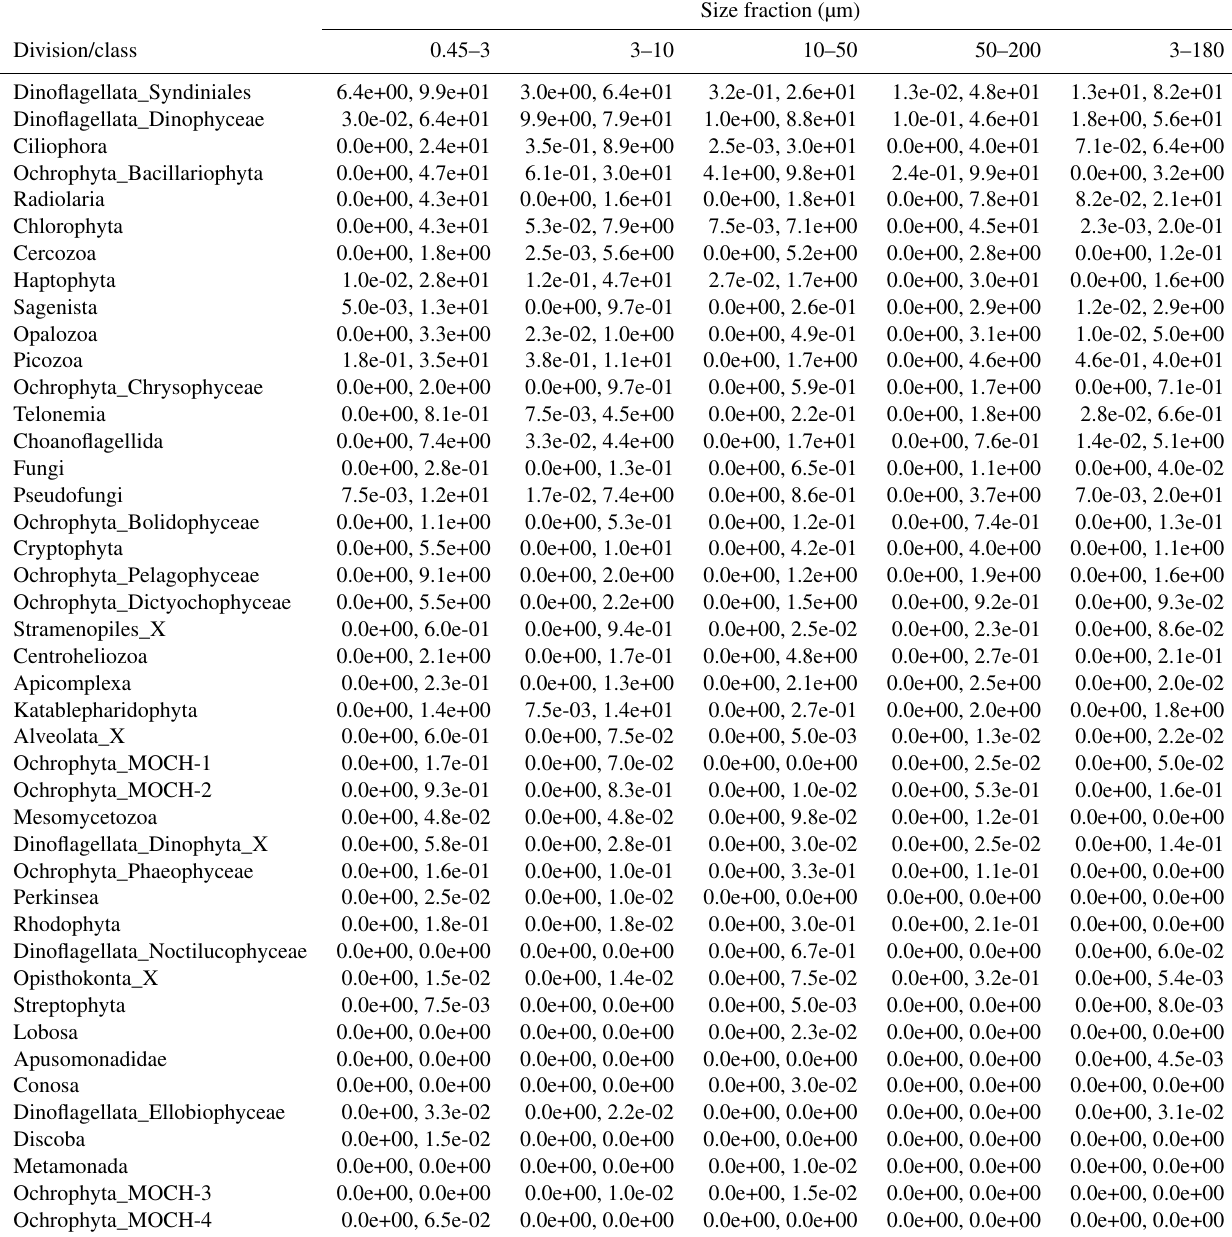
Table A2. Minimum and maximum percentage of reads of each division or class in each size fraction. The entries have the format “min%,